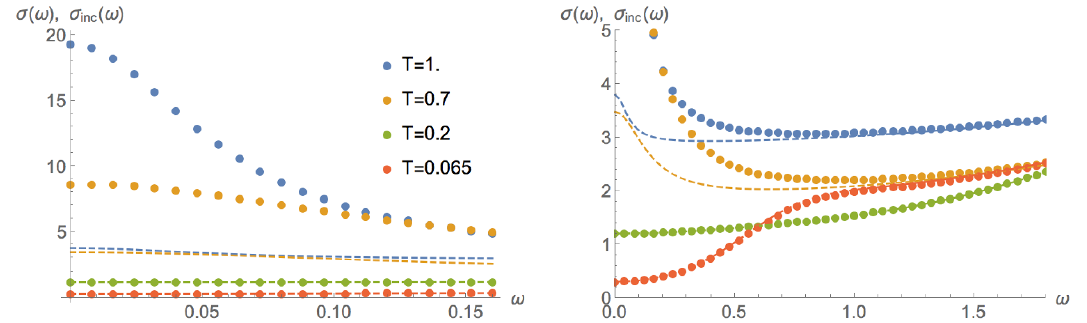
Figure 5 . AC optical and incoherent conductivities for the explicit insulator (2.8) at selected values of the temperature. We show the optical conductivity with a solid line, and the incoherent one with a dashed line. The left panel zooms into the low frequency range, while the right panel show the high frequency